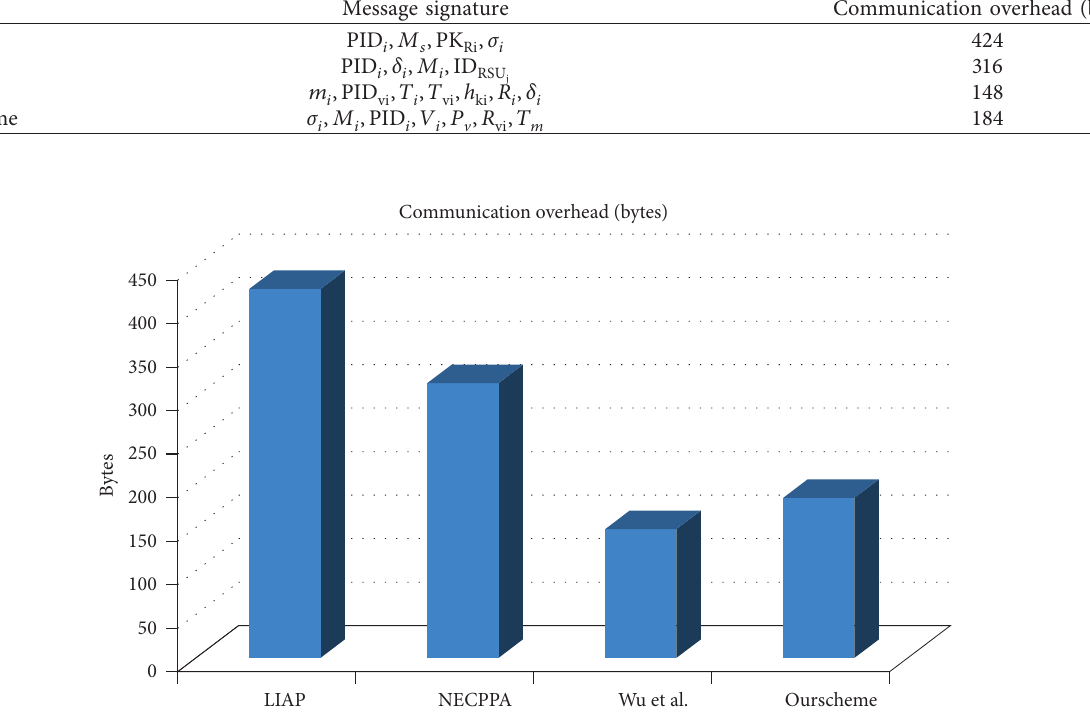
Figure 4: Comparison of communication